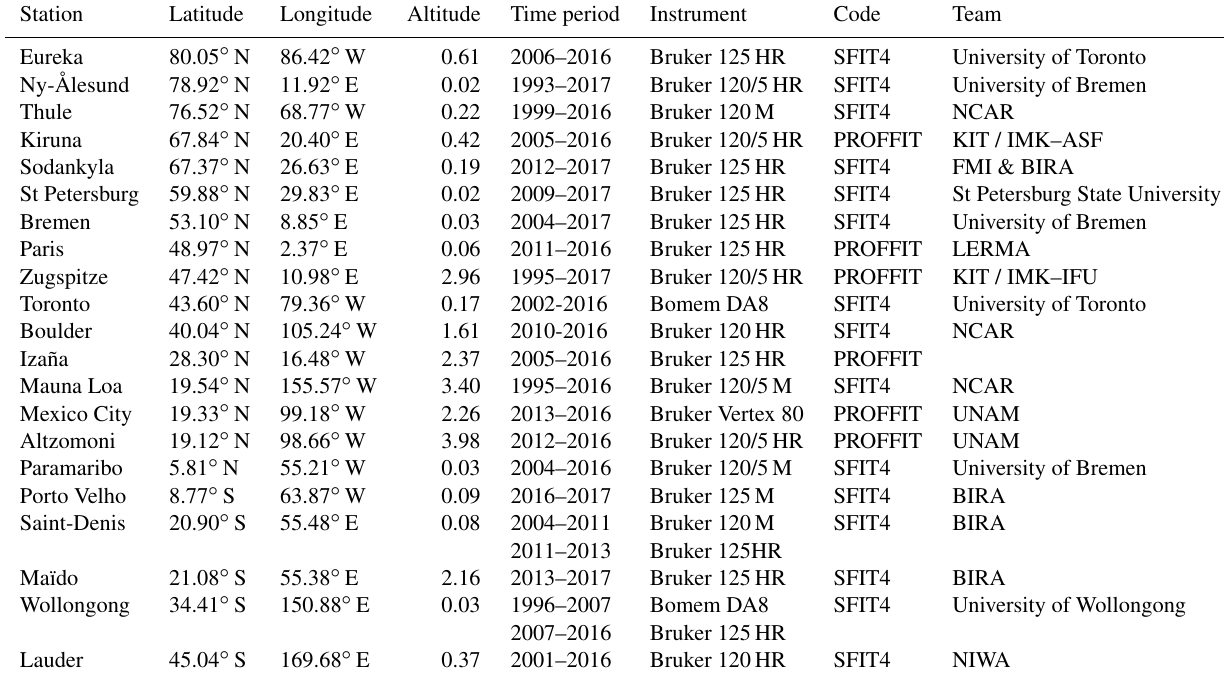
Table 1. Characteristics of the FTIR stations contributing to the present work: location and altitude (in kma.s.l.), time period used in the present study, instrument type, retrieval code, and team.